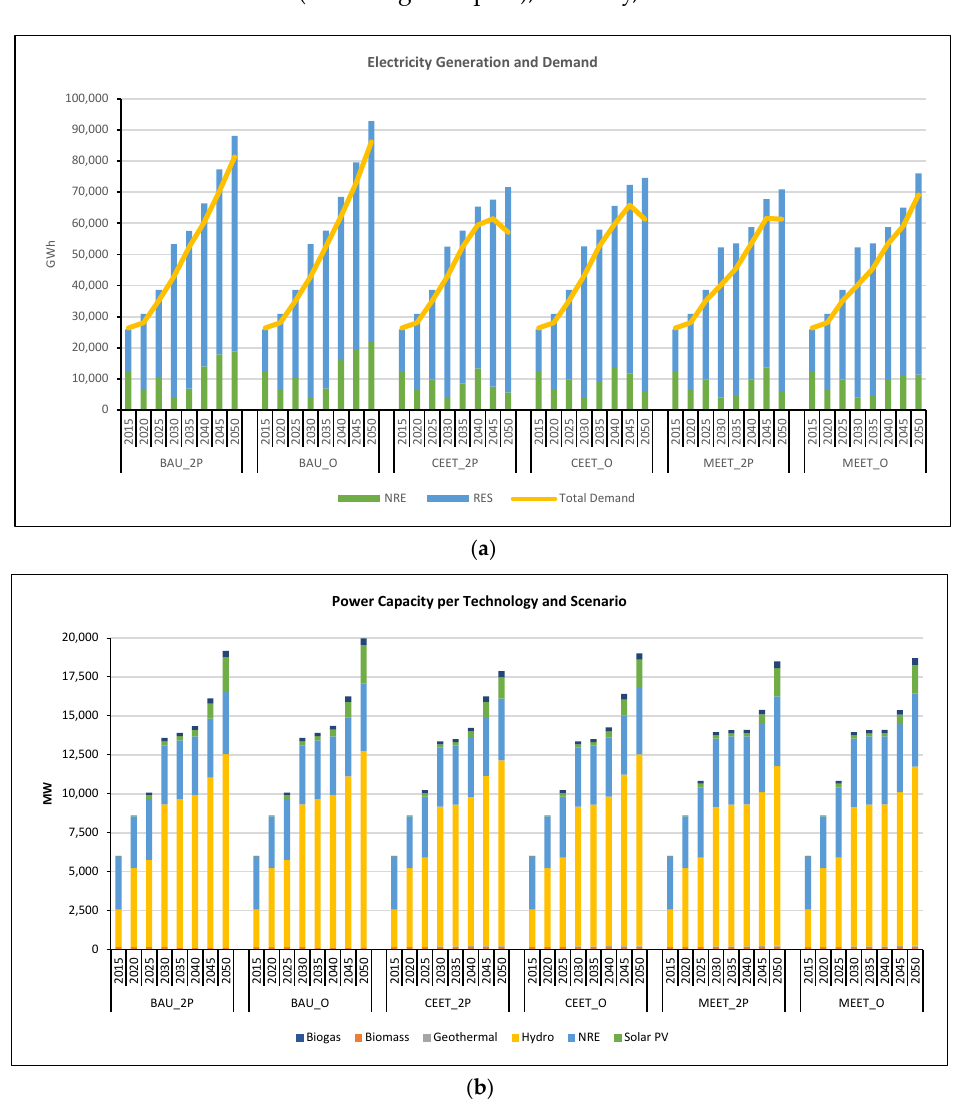
Figure 3. Evolution of ( a ) Electricity generation and demand, ( b ) Installed capacity per scenario.